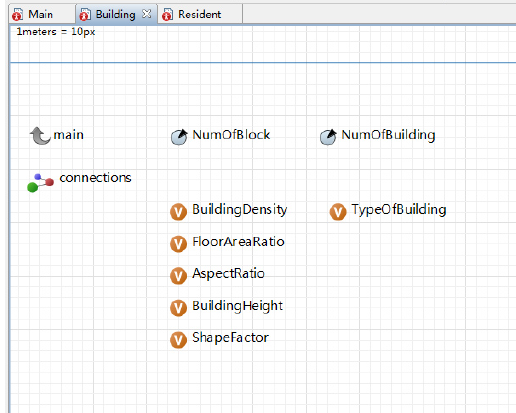
Figure 1. The general idea of the model design.